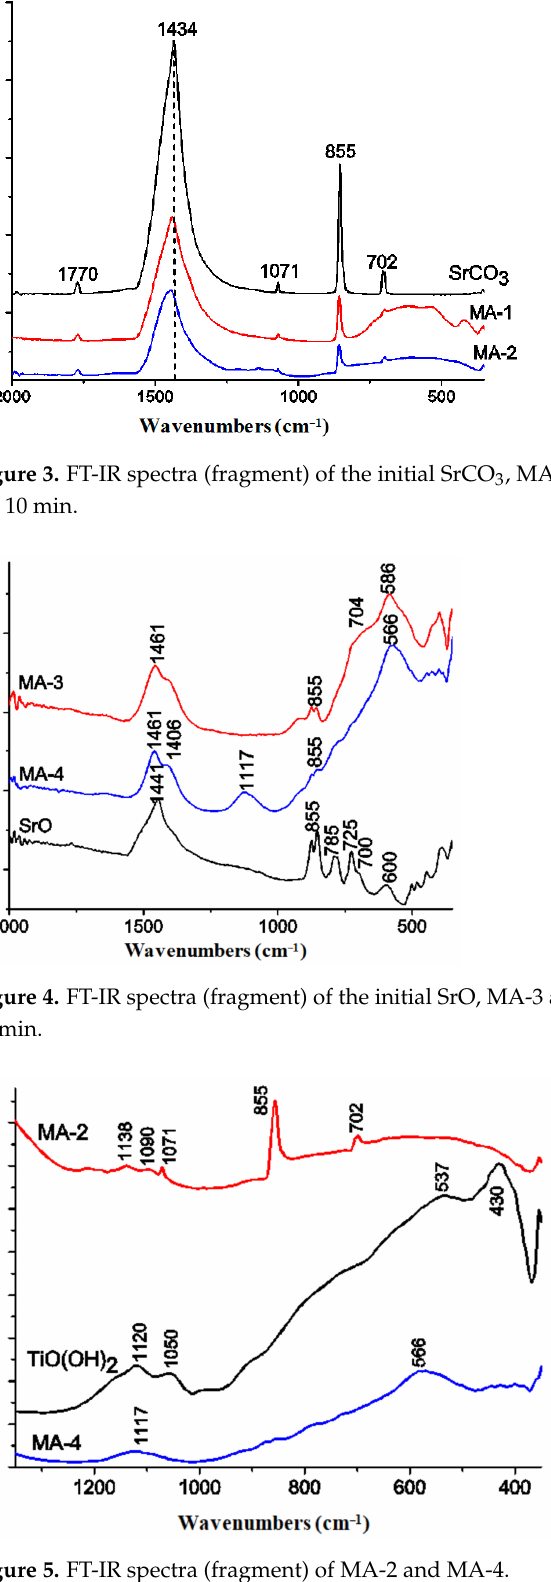
Figure 5. FT-IR spectra (fragment) of MA-2 and MA-4. The spectrum of the initial SrCO 3 shows absorption peaks at 1770, 1434, 1071, 855, 704 and 702 cm − 1 (Figures 2 and 3). The absorption band at 1770 cm − 1 is assigned to the bond stretching vibration of C=O in CO 3 2 − [36]. The intensive a.b. at 1434 cm − 1 and the